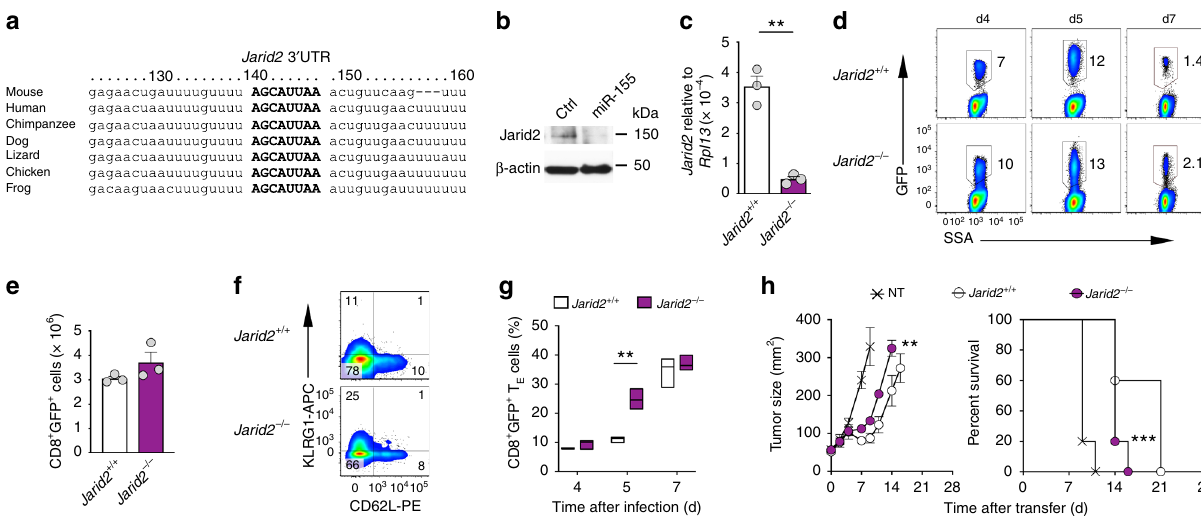
Fig. 3 Deletion of Jarid2 does not recapitulate the functional advantages conferred by miR-155 in CD8 + T cells. a Sequence alignment of the Jarid2 3 ′ UTR in multiple species. The predicted miR-155 target site sequence is shown in capital bold. b Jarid2 protein level in miR-155-overexpressing cells assessed by Immunoblot. c Quantitative RT-PCR of Jarid2 mRNA in pmel-1 Jarid2 + / + and pmel-1 Jarid2 – / – cells. Bars (mean ± s.e.m. of technical triplicates) are relative to Rpl13 mRNA. d Flow cytometry of splenic CD8 + GFP + T cells assessed at different time points following adoptive transfer of 3 × 10 5 pmel-1 Jarid2 fl / fl CD8 + T cells transduced with GFP-Cre or Ctrl GFP into wild-type mice in conjunction with gp100-VV. Numbers indicate the percentage of cells after gating on live CD8 + GFP + T cells. e Number of splenic pmel-1 CD8 + GFP + T cells at day 5 after transfer as in d . Bars represent the mean ± s.e.m. of three individual mice. f Flow cytometry of splenic pmel-1 CD8 + GFP + T cells 5 days after transfer as described in d . Numbers indicate the percentage of cells after gating on live CD8 + GFP + T cells. g Percentage of splenic pmel-1 CD8 + GFP + T E cells at indicated time points after transfer as in d . Data are presented as box plots